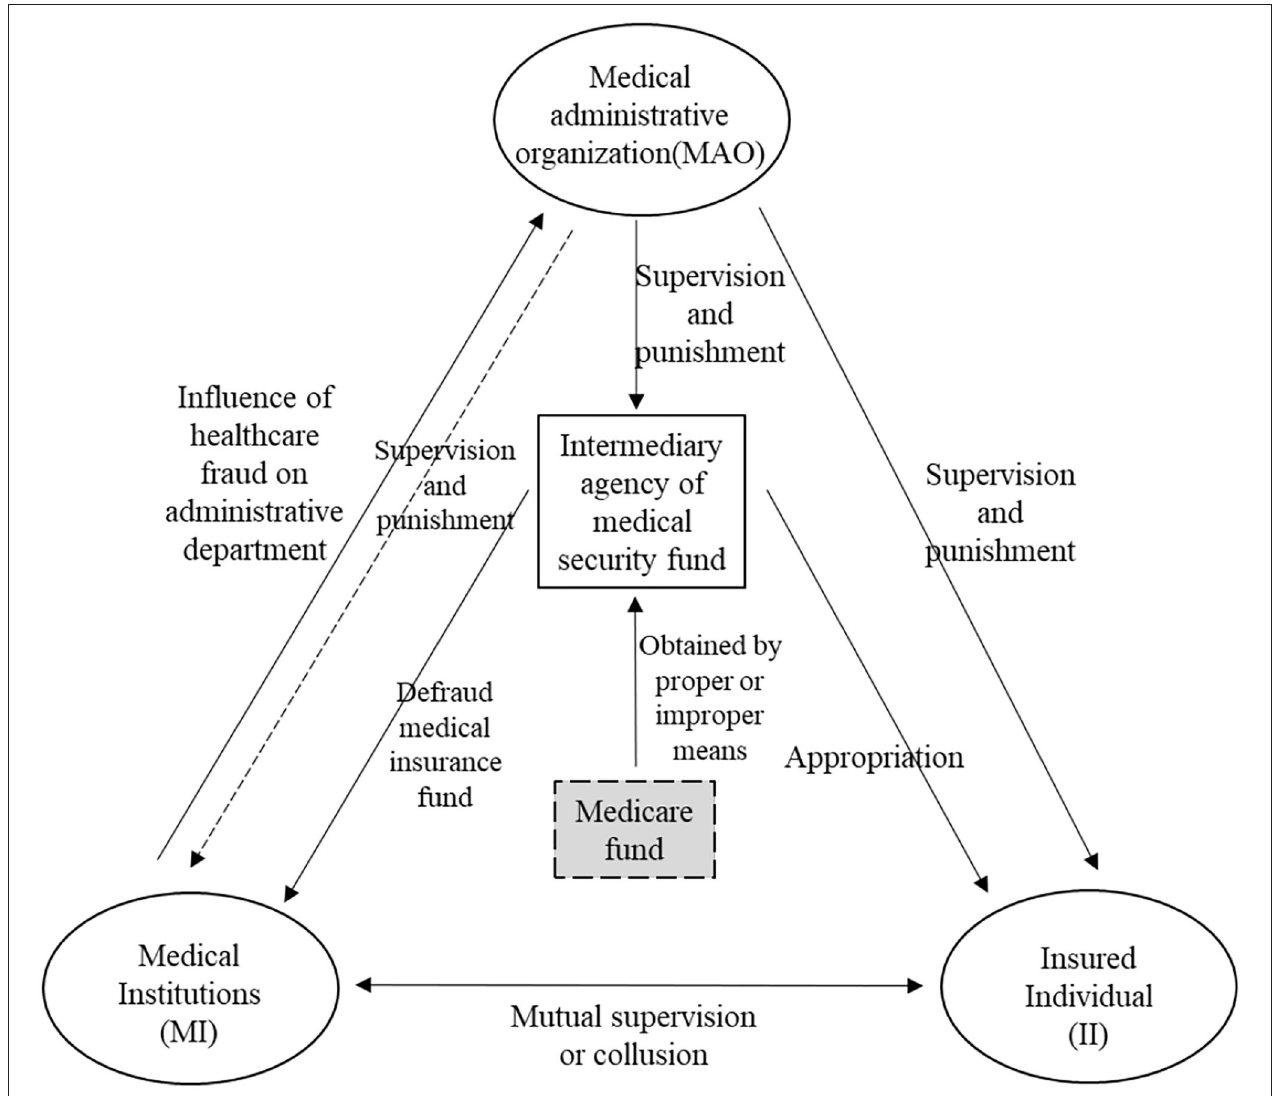
FIGURE 1 | The relationship between the three